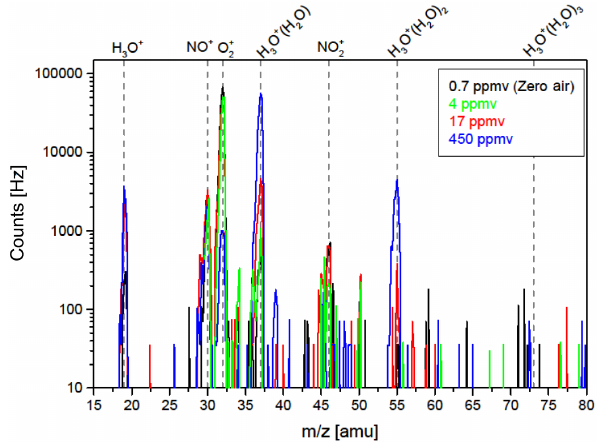
Figure 6. Mass spectra for m/z ratios from 15 to 80amu for four different water vapor mixing ratios. The black curve represents a measurement of an added zero air flow, the other three spec- tra are samples of ambient atmospheric air during flight. As H 2 O mixing ratios increase, the signals on H 3 O + , H 3 O + (H 2 O) and (@450ppmv) H 3 O + (H 2 O) 2 increase whereas the O + signal de- 2 creases. The signal on H 3 O + (H 2 O) 3 does not increase up to mix- ing ratios of 450ppmv. NO + and NO + stay almost constant over 2 the range of water vapor mixing ratios shown